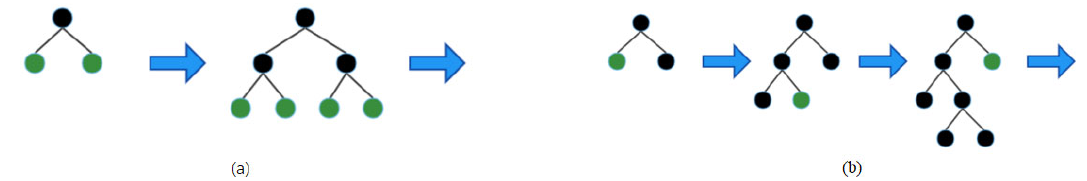
Figure 1. ( a ) XGBoost level-wise tree growth; ( b ) LightGBM leaf-wise tree growth.